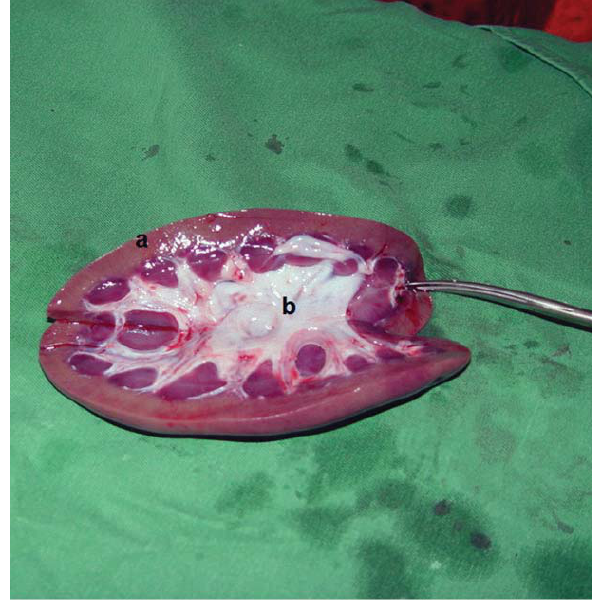
Fig. 3 - Corte longitudinal do rim: (a) Córtex, (b) Medula